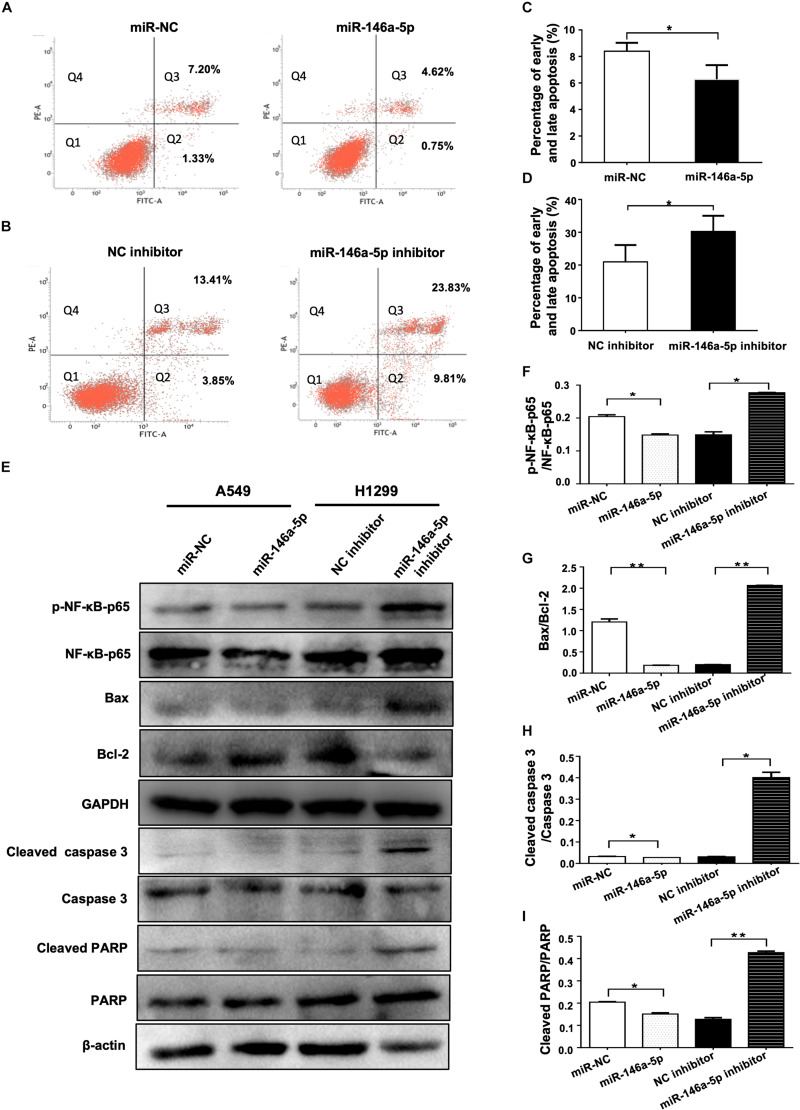
miR-146a-5p inhibits apoptosis in NSCLC cells. (A) Cell death determined in A549 cells at 48 h after transfection of miR-146a-5p mimic (miR-146a-5p) or miR-NC, stained with propidium iodide (PI) and annexin-FITC. Q1: Live cells; Q2: early apoptotic cells; Q3: late apoptotic cells; Q4: necroptotic cells. (B) Apoptosis in H1299 cells at 48 h after transfection of miR-146a-5p inhibitor or NC inhibitor by FACS as in (A). (C, D) Quantification of the early and late apoptosis of (A, B). (E) Level of NF-κB-p65(pS536), NF-κB-p65, Bax, Bcl-2, cleaved Caspase 3, Caspase 3, cleave PARP and PARP detected by Western blot in A549 cells and H1299 cells at 48 h post transfection of miR-146a-5p mimic or miR-146a-5p inhibitors, respectively. GAPDH or β-actin used as loading controls. (F). Quantification of pNF-κB-p65(pS536)/NF-κB-p65 ratio as in (E). (G) Quantification of Bax/Bcl2 ratio as in (E). (H) Quantification of cleaved Caspase 3/Caspase 3 ratio as in (E). (I) Quantification of cleaved PARP/PARP ratio as in (E).